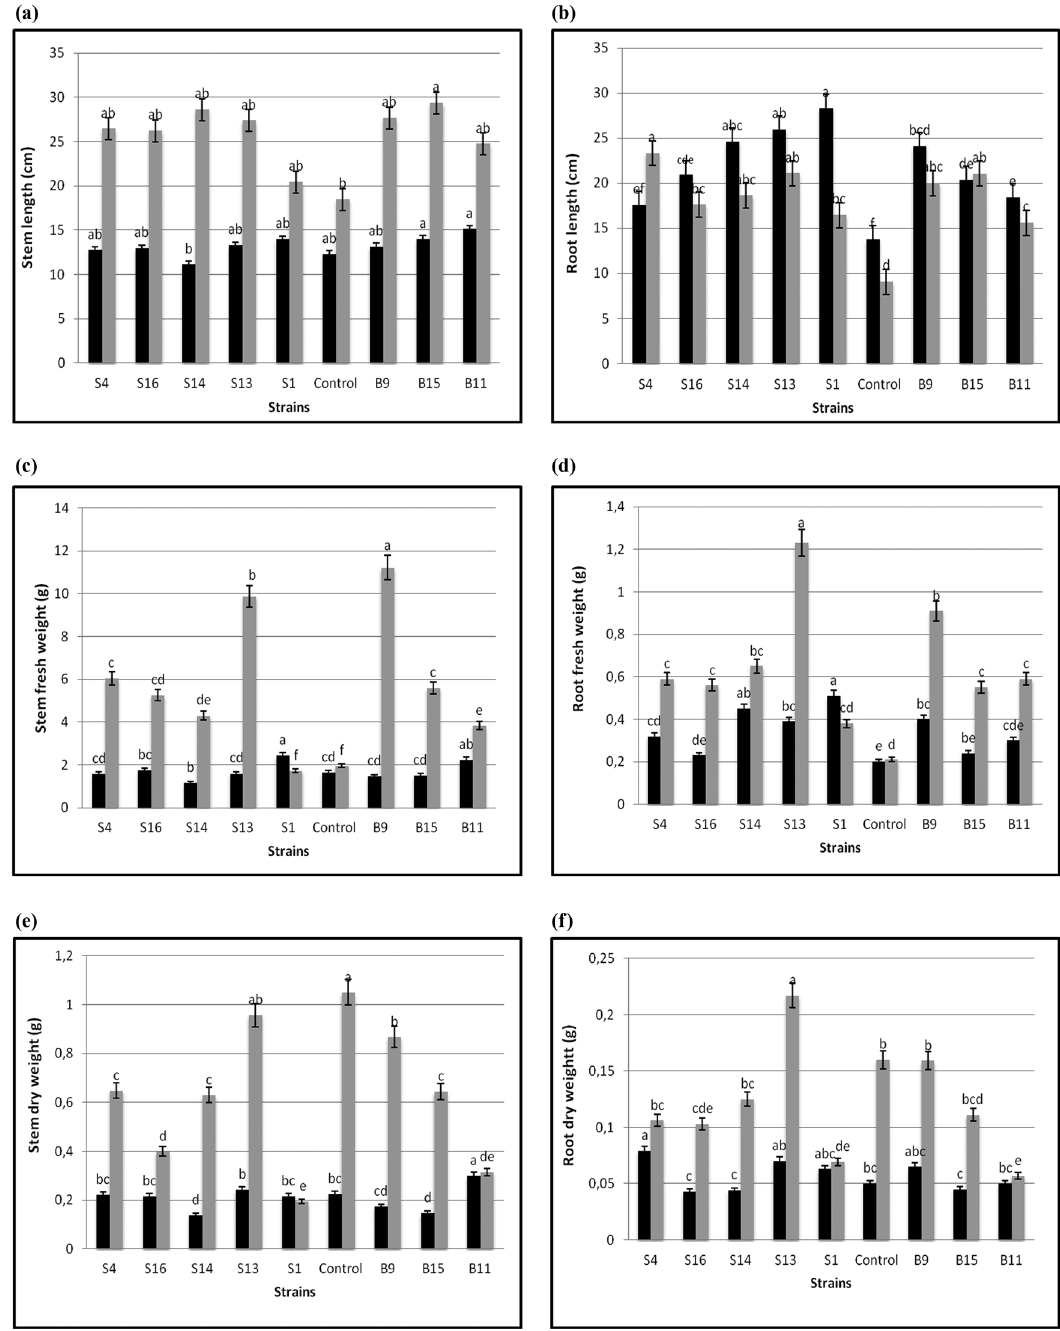
Figure 4: Growth parameters as a function of bacterial inocula of the Raja variety. Di ff erent letters indicate signi fi cant di ff erences between categories ( P < 0.05 ) . Error bars indicate ± SD. ( a ) stem length, ( b ) root length, ( c ) stem fresh weight, ( d ) root fresh weight, ( e ) stem dry weight and ( f ) root dry